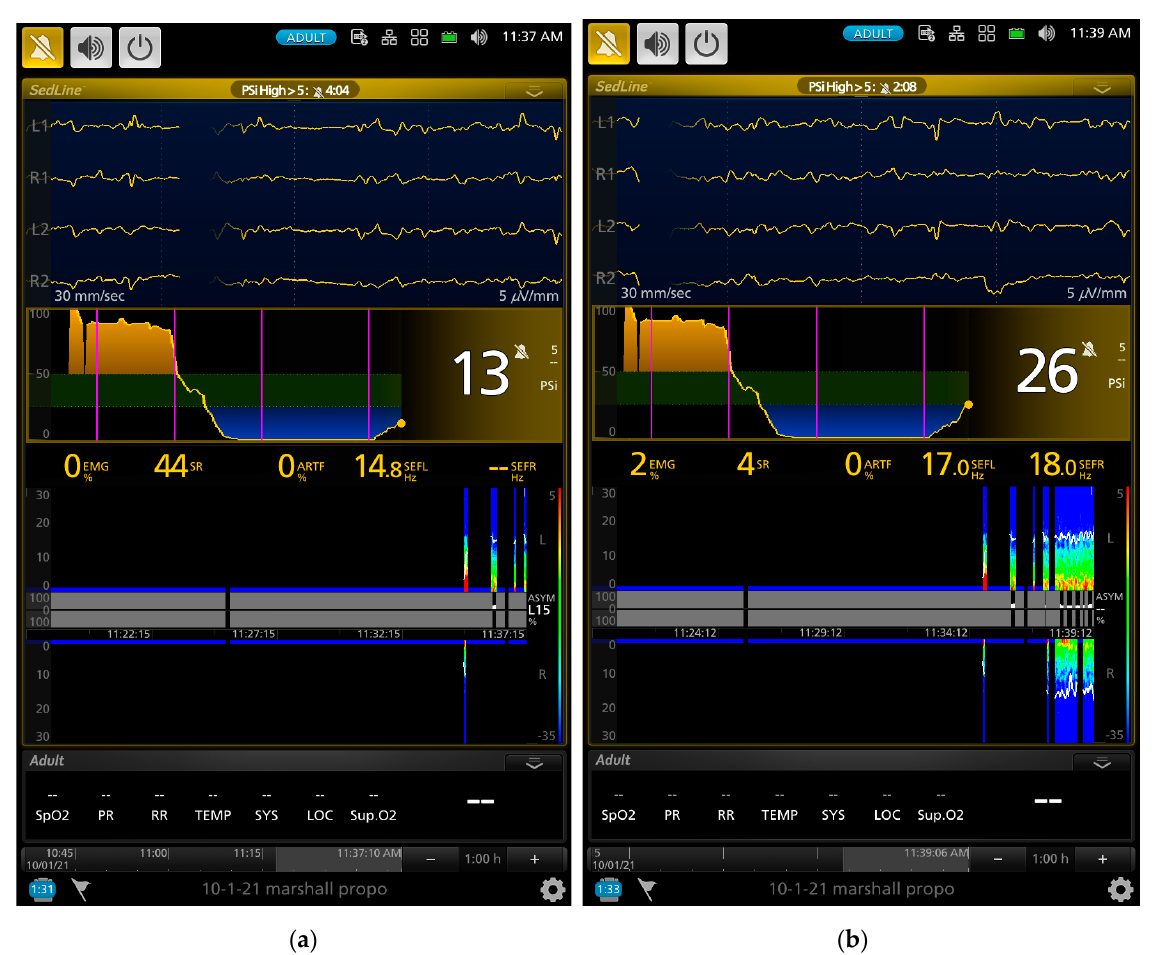
Figure 4. A continuation of EEG screenshots of the same dog shown in Figures 2 and 3. The 4 vertical pink lines (from the left to right of the screen) indicate the initiation of propofol induction, beginning of the 2.4, 1.6, and 0.8 mg/kg/min of propofol CRI, respectively. The trend in the PSI values over time (the middle of the screen) showed the PSI values went from an awake level near 100 to zero during the 2.4 and 1.6 mg/kg/min of propofol CRI and then gradually return to 13 and then 26 when the CRI propofol dosages were reduced to 0.8 mg/kg/min. The raw EEG pattern showed returning of a slow delta–theta wave oscillatory activity (similar to the EEG pattern of Figure 3a) from the previous isoelectric flat line waveform with the occasion of EEG bursts (Figure 3b). The burst suppression ratio value decreased from 44% ( a ) to 4% ( b ). The SEFL 95 and SEFR 95 were 17.0 and 18.0 Hz in ( b ). There were significant changes between the seven phases in all the EEG indices.